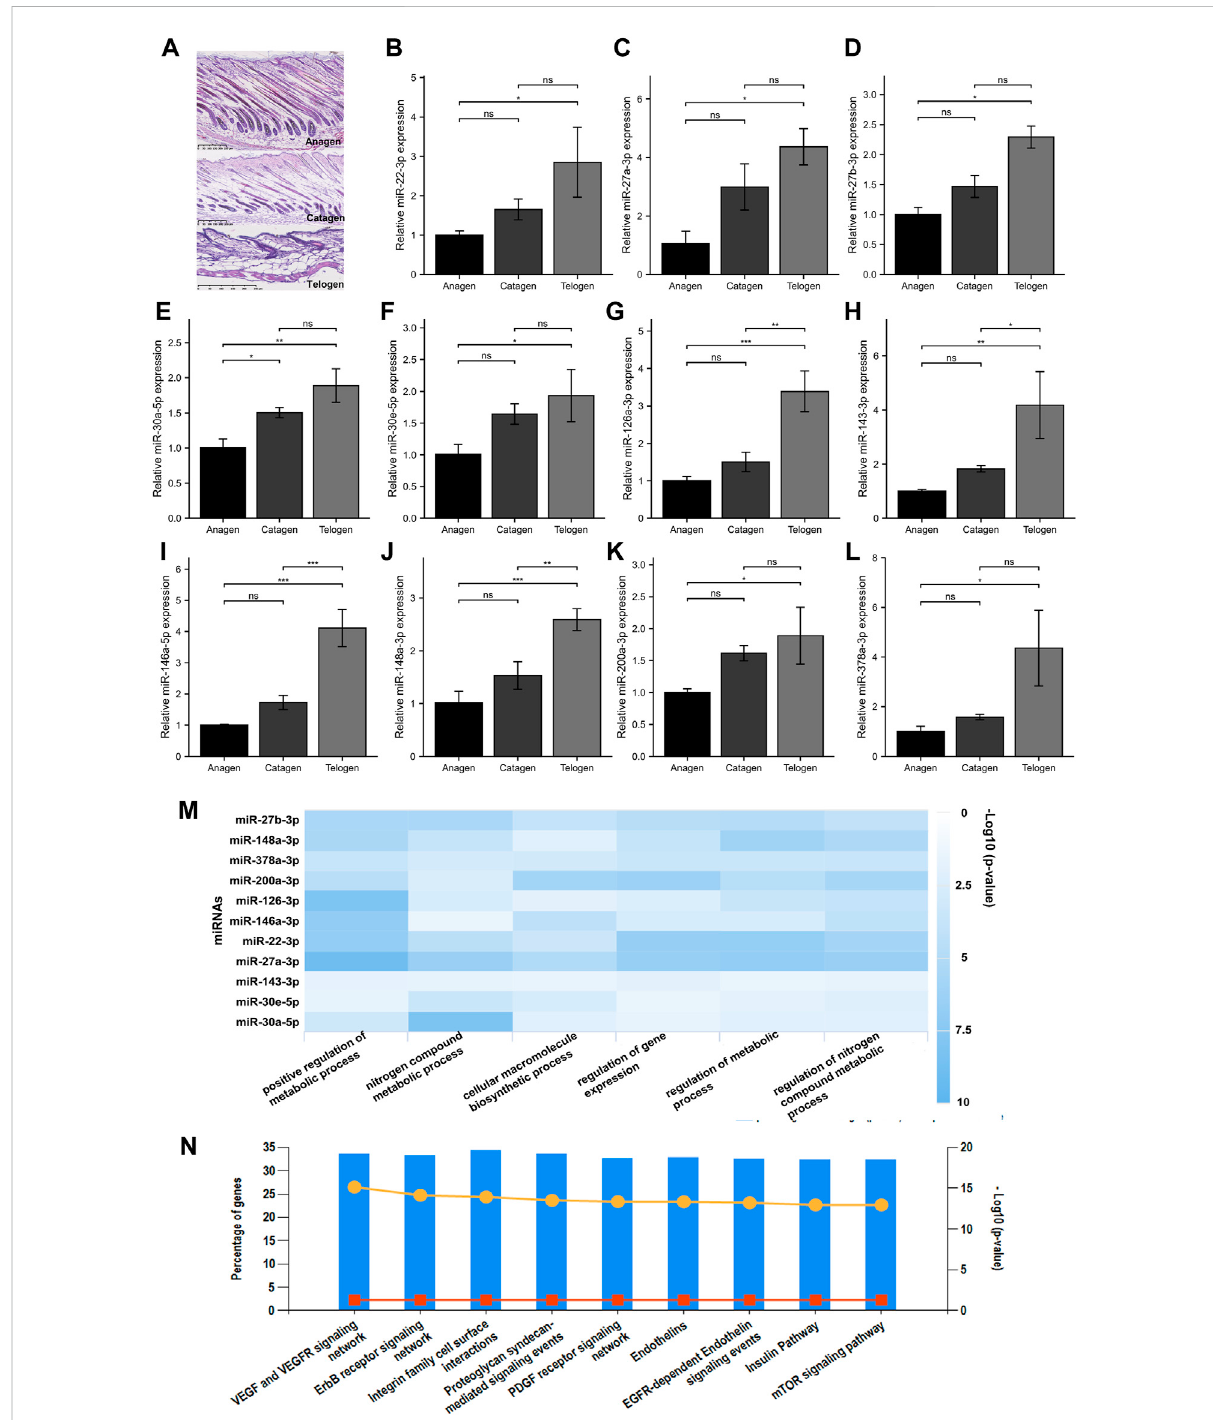
FIGURE 2 Screening for miRNA with increased expression from the anagen to telogen phase in murine hair follicle cycle. (A) HE staining of murine hair follicle morphology shows anagen (P14), catagen (P17), and telogen (P23). (B – L) Validation of screened miRNAs using RT-qPCR. The expressions of miR-22-3p, miR-27a-3p, miR-27b-3p,miR-30a-5p, miR-30e-5p, miR-126a-3p, miR-143-3p, miR-146a-5p, miR-148a-3p, miR-200a-3p, and miR- 378a-3patdifferentstagesofthehairfolliclecycle. (M) TheGObiologicalprocessesenrichmentanalysisof11screenedmiRNAs. (N) TheKEGG pathwayenrichmentanalysisof11screenedmiRNAs.ns, p ≥ 0.05;*, p < 0.05;**, p < 0.01;***, p < 0.001.HE,hematoxylinandeosin; p ,postnatal;GO, Gene Ontology; KEGG, Kyoto Encyclopedia of Genes and